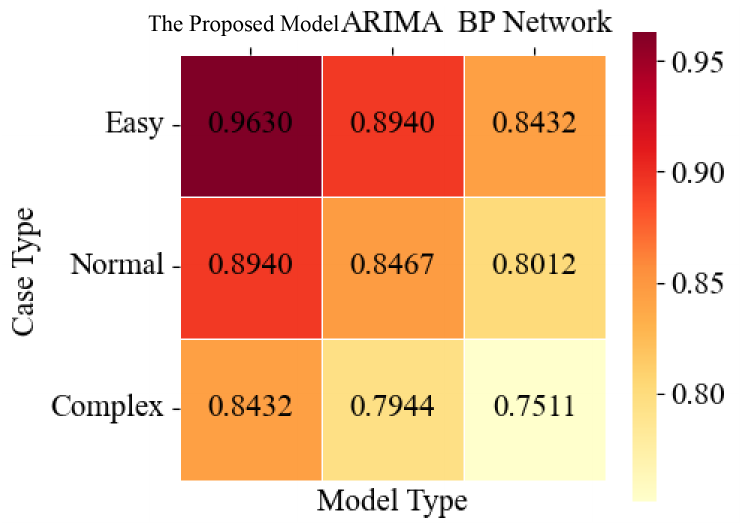
Figure 8. Comparison of the prediction accuracies of different